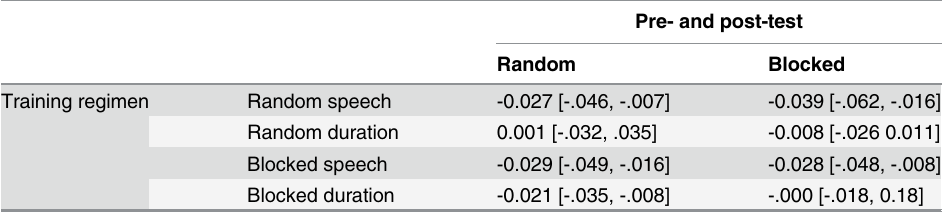
Table 3. Mean group slopes of the regression lines fi tted to individual learning curves [with 95% con fi dence